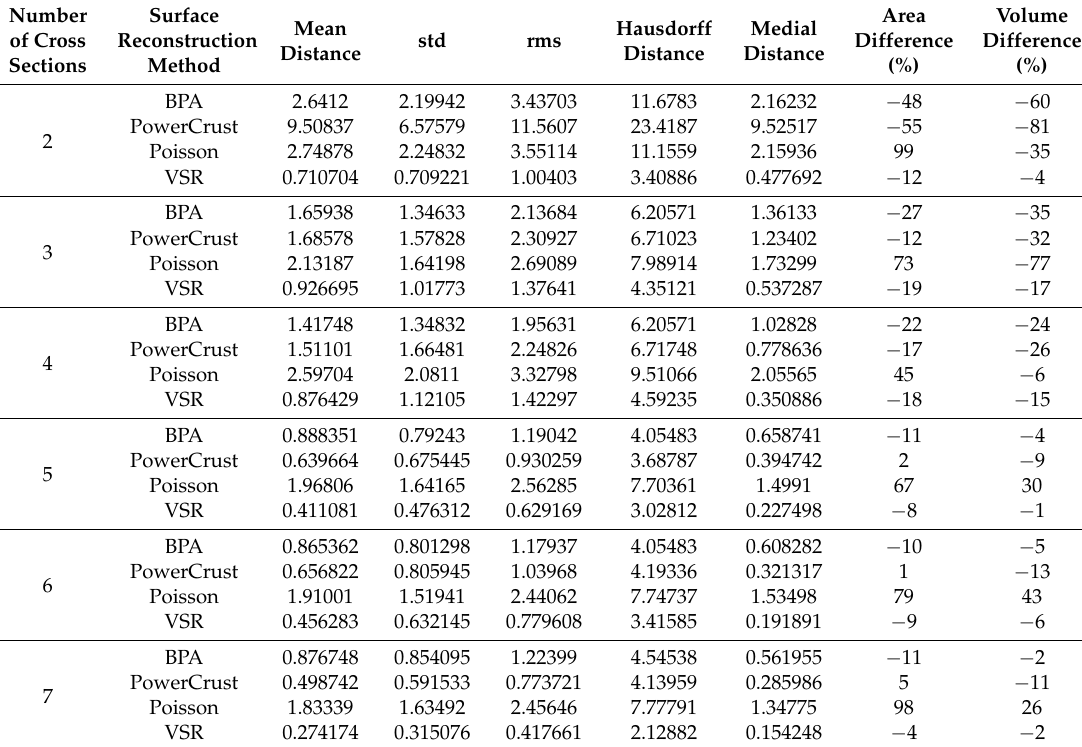
Figure 5. Hausdorff distance between the reconstructed surface and the original surface (ACORN). Table 1. Difference between the reconstructed surface and the original surface (ACORN).